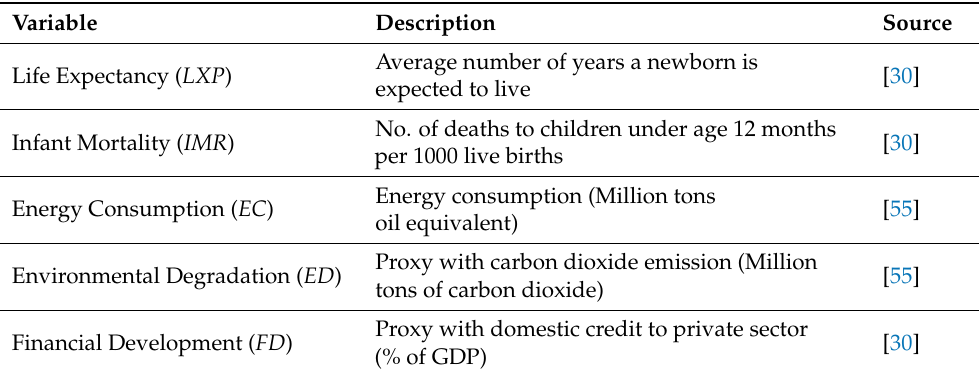
Table 1. Description of Variables.